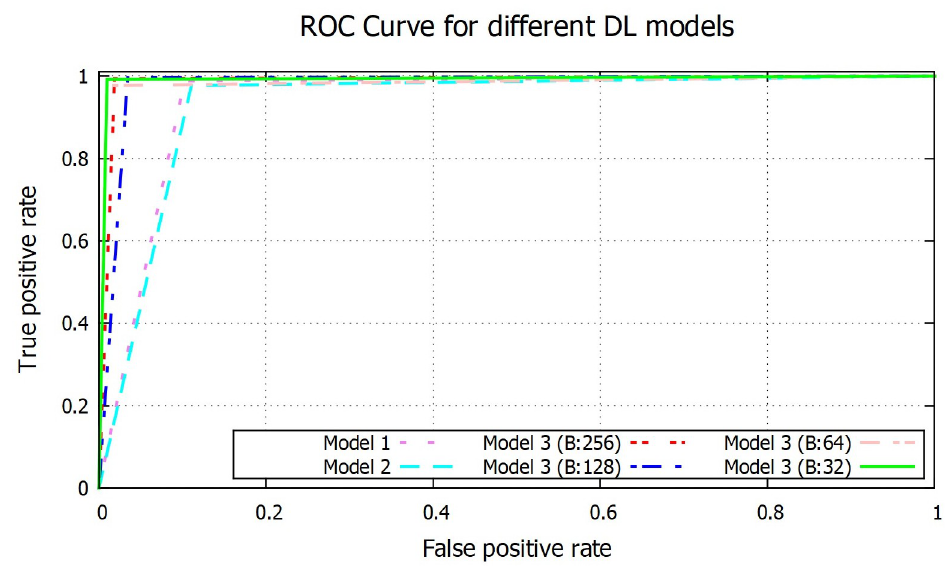
Fig 12. ROC graph of CNN model 3 with batch size 64.